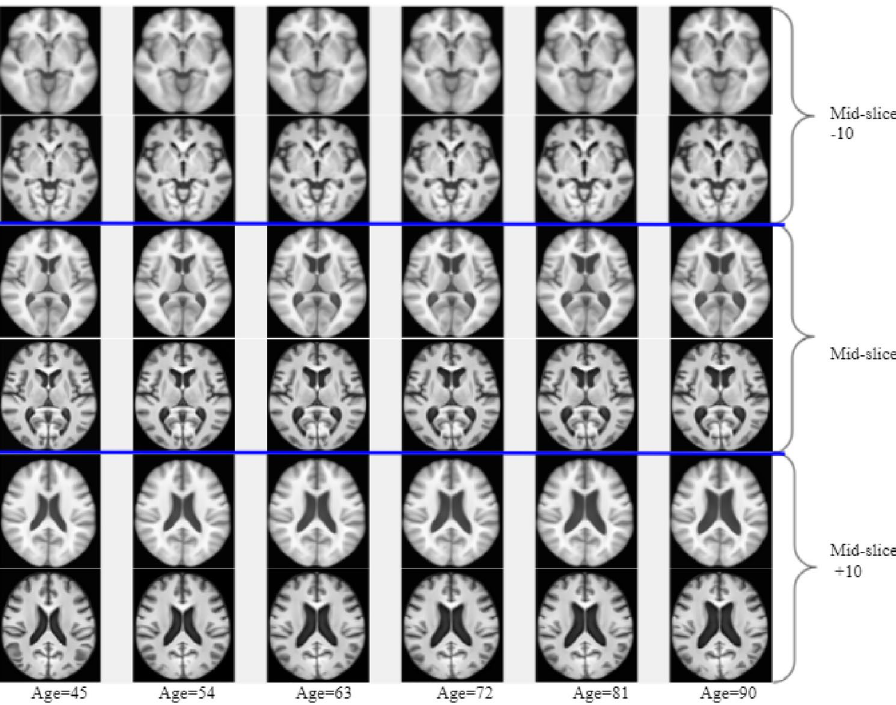
Figure 6. Correctness of aging trends captured in the model: Publicly available spatio-temporal images 14 (row 1, 3, 5) compared with images generated at same time points with proposed aging model using Neurodev data at different time points (row 2, 4, 6) Each highlighted row pairs compare same slices as specified in the